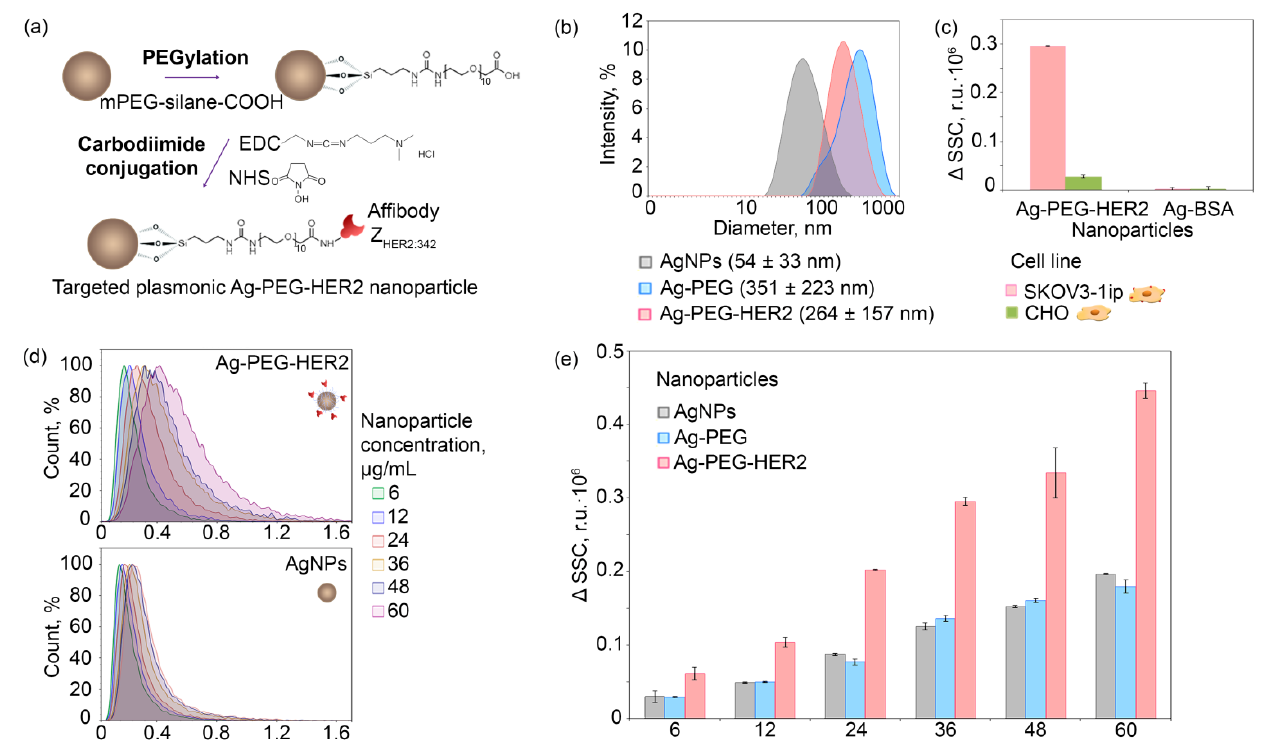
Figure 4. Nanoparticle conjugation to HER2-recognizing scaffold protein Z HER2:342 and HER2-overexpressing cell targeting in in vitro tests. ( a ): The schematic illustration of NP surface coating with artificial scaffold polypeptide—affibody Z HER2:342 through the intermediate PEGylation and subsequent carbodiimide conjugation. ( b ): DLS distributions showing the dependence of the intensity (%) of pristine (Ag NPs), PEGylated (Ag-PEG), and affibody-decorated (Ag-PEG-HER2) silver nanoparticles on their hydrodynamic diameter (nm). ( c ): Flow cytometry side scatter change ΔSSC of SKOV3-1ip and CHO cell populations labeled with targeted Ag-PEG-HER2 and nontargeted Ag-BSA nanoparticles (r.u.·10 5 ). ( d ): Flow cytometry histograms in SSC channel of SKOV3-1ip cells labeled with different concentrations of Ag NPs (top) and Ag-PEG-HER2 (bottom) nanoparticles. ( e ) The dependence of ΔSSC ( r.u.·10 3 ) on SKOV3-1ip cell populations labeled with different concentrations of Ag-PEG-HER2, Ag-PEG, and Ag (μg/mL) obtained with the flow cytometry. ΔSSC was calculated as raw SSC intensity with subtracted SSC intensity of unstained cell samples.